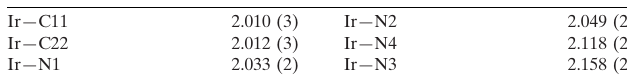
Selected bond lengths (A˚ ).